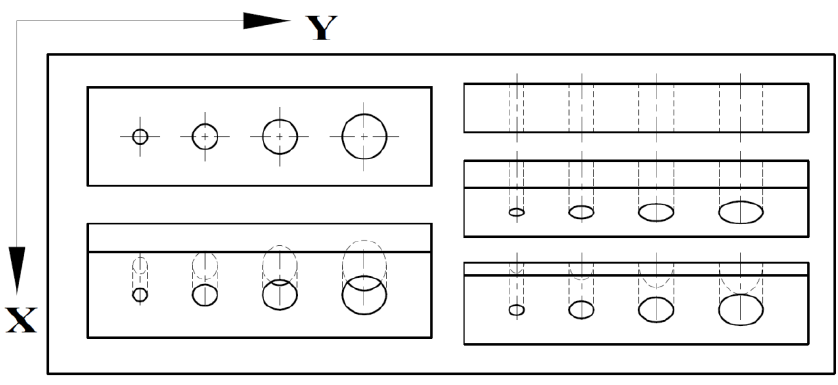
Figure 3. Schematic representation of sample arrangement in the printing chamber.